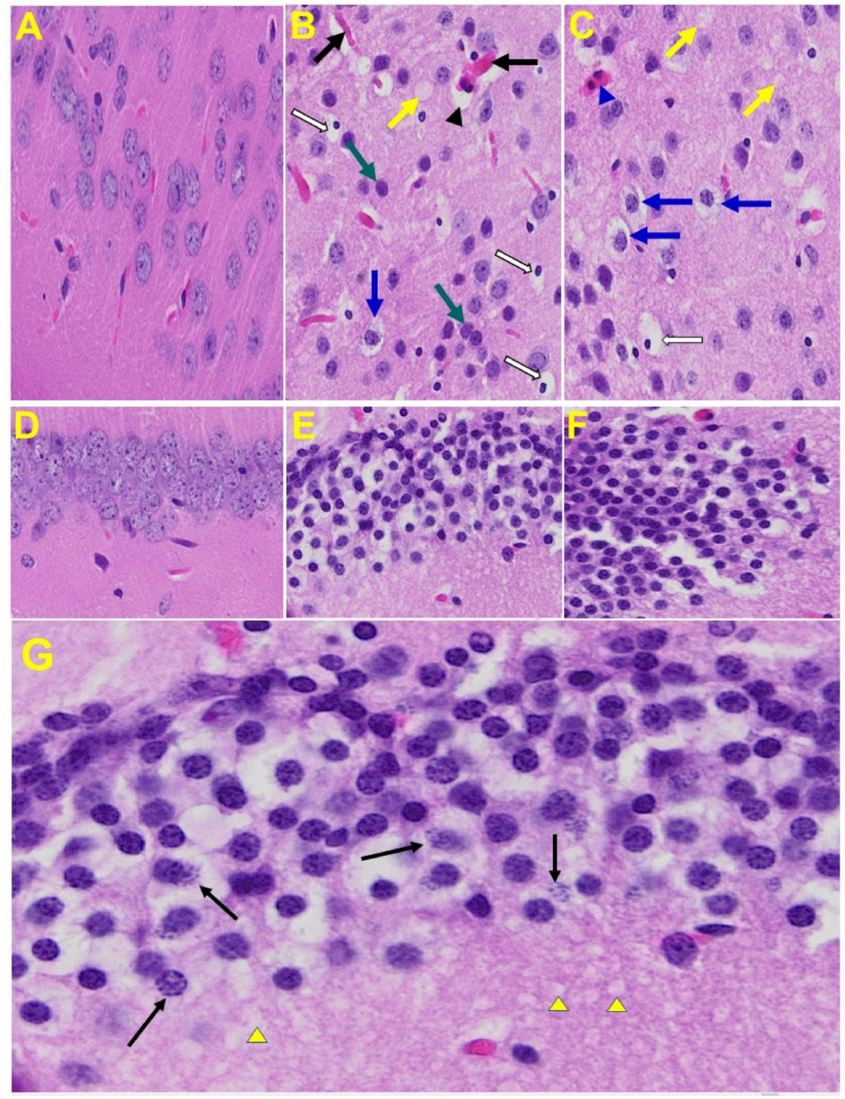
Figure 7. MHV-1 infected mouse brain. ( A ) Normal mouse. ( B , C ) The infected mouse brain cortex at day 7 shows congested blood vessels (black arrows), perivascular cavitation (black arrowhead) suggestive of edema, pericellular halos (blue arrows), vacuolation of neuropils (yellow arrow), darkly stained nuclei (curved arrows green arrows), pyknotic nuclei amid associated vacuolation of the neuropil (white arrows), and acute eosinophilic necrosis (blue arrowhead). ( D ) Normal mice. ( E , F ) The brain hippocampus of an MHV-1 infected mouse (enlarged image, ( G )) shows a necrotic neuron with fragmented nucleus (arrow) and vacuolation (arrowhead) (H&E original magnification of A–F is 400 × as noted in Figure